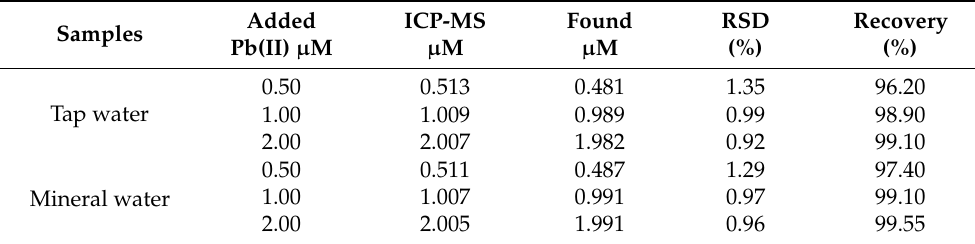
Table 1. Sensing of Pb(II) in environmental samples based on Pep-CuNCs as a promising sensor ( n =